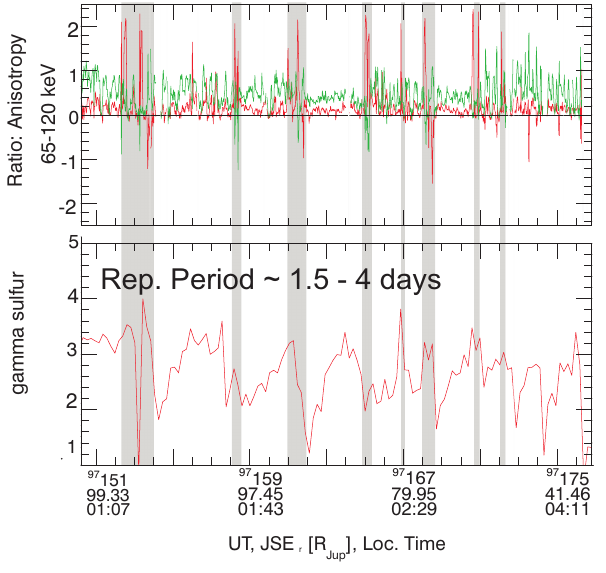
Fig. 4. Format as in Fig. 2. The time interval DOY 215, 00:00UT to DOY 241, 00:00UT in 1997 (orbit C9) is shown.